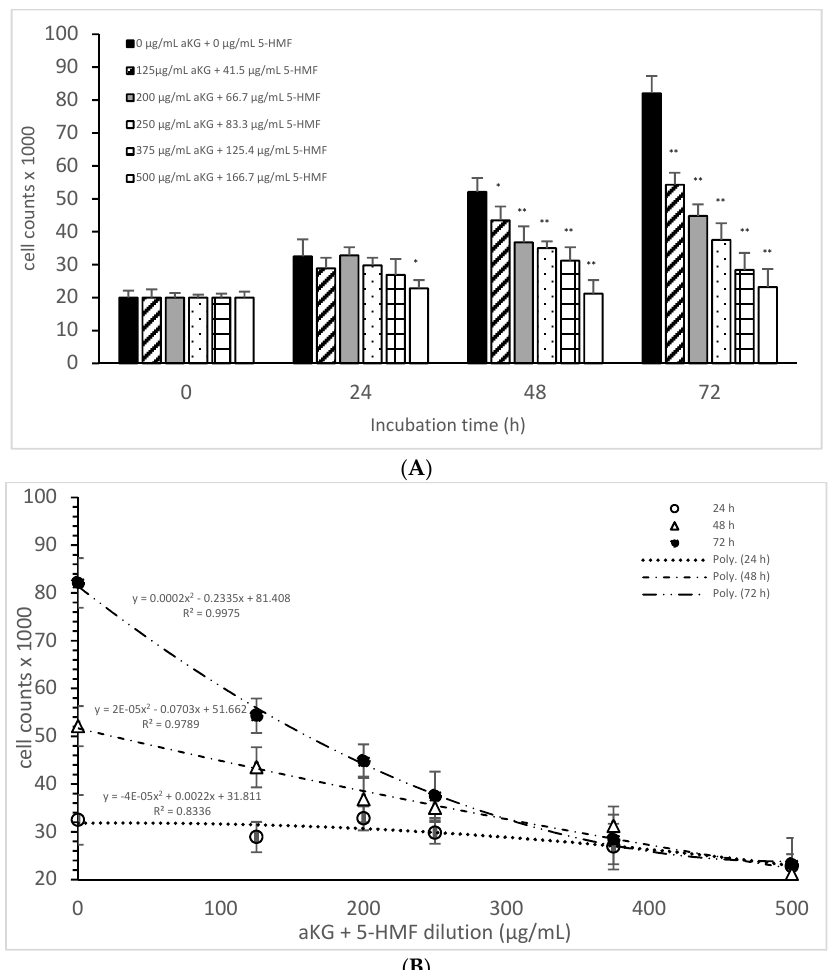
Figure 2. Cell growth of the Jurkat cell line in the absence or presence of different concentrations of the combined aKG + 5-HMF ( A , B ) correlation between cell growth and the combined solutions of aKG + 5-HMF after 24, 48, and 72 h of cultivation ( n = 5). * p < 0.05: significance between the control (0 µg/mL aKG + 0 µg/mL 5-HMF) and different combinations of aKG + 5-HMF at the time points after 1, 2, and 3 days of cell culture. ** p < 0.001: significance between the control (0 µg/mL aKG + 0 µg/mL 5-HMF) and different combinations of aKG + 5-HMF at the time points after 1, 2, and 3 days of cell culture.